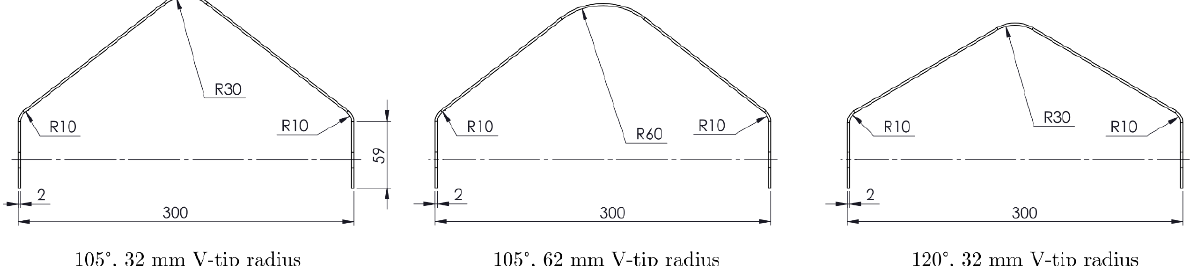
Figure 1. Side profile of a 2 mm thick V-structure with a 105° internal angle with an external tip radius of 32 mm, i.e., a bend radius = 30 mm (dimensions are in mm).